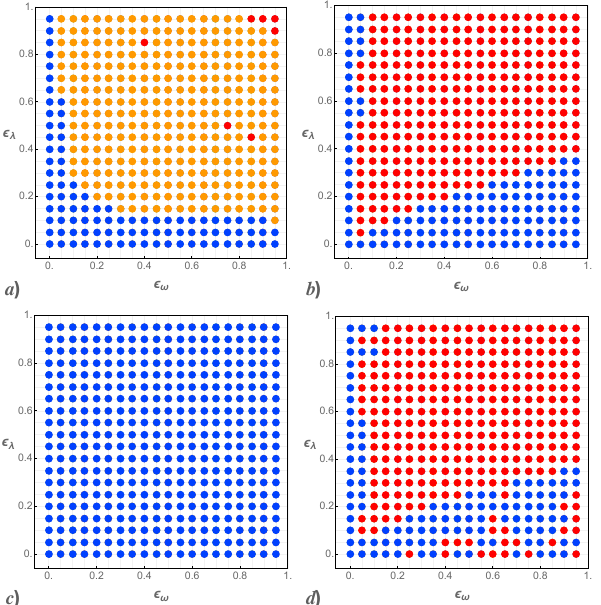
Figure 4. Four different parametric planes obtained after assuming different knowledge-transfer methods. Blue points correspond to sustainable situations, yellow points to non-sustainable situations by exhaustion and red points indicate non-sustainable catastrophic situations. ( a ) D-D knowledge- transfer mode, ( b ) D-P knowledge-transfer mode, ( c ) P-D knowledge-transfer mode and ( d ) P-P knowledge-transfer mode. The figure is own